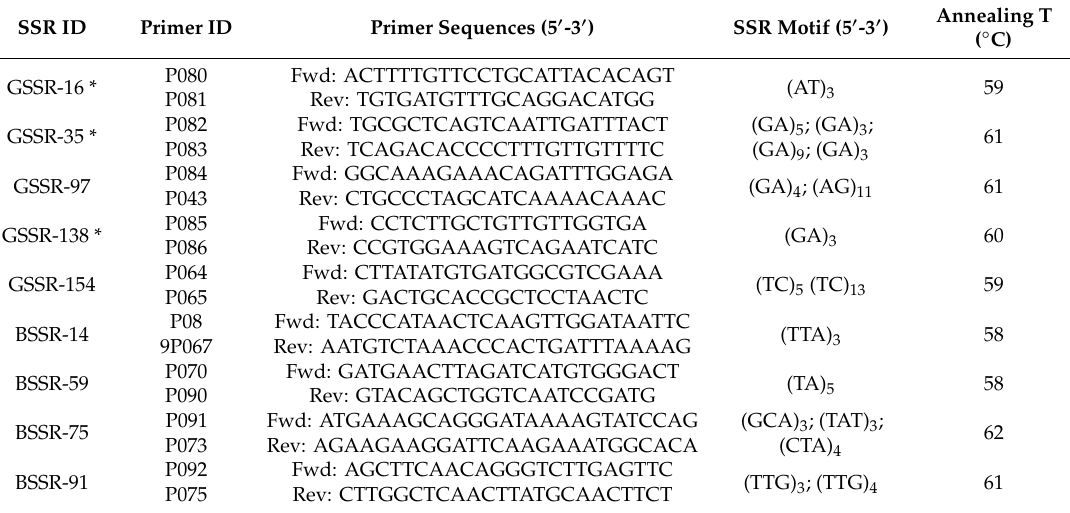
Table 2. SSR loci characteristics and primer sequences.